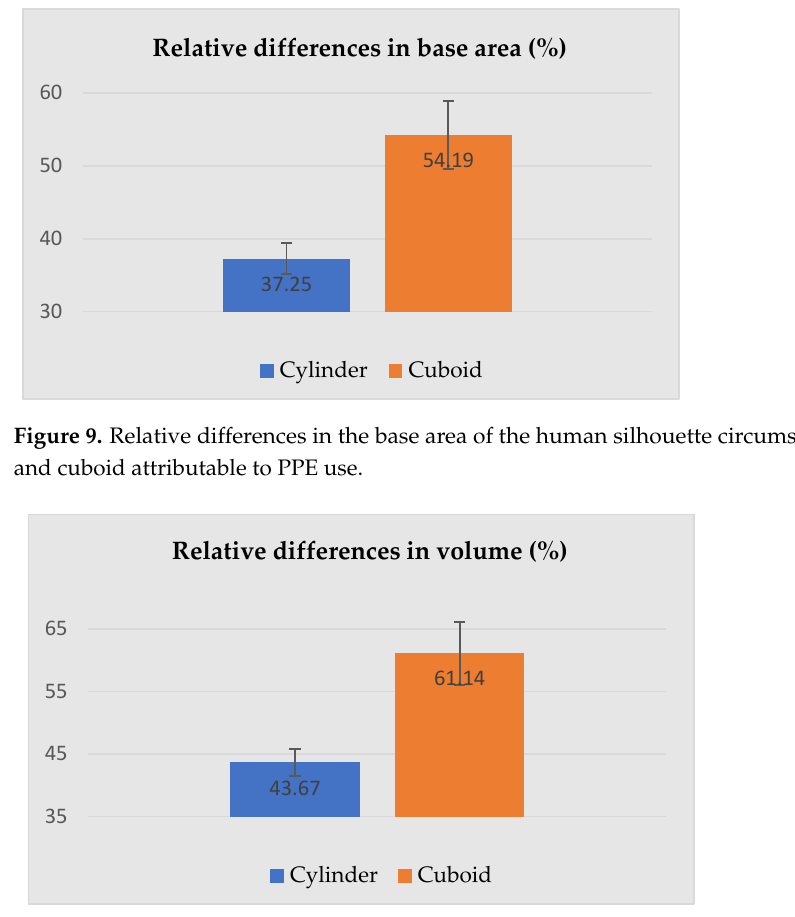
Figure 10. Relative differences in the volume of the human silhouette circumscribed by a cylinder and cuboid attributable to PPE use.